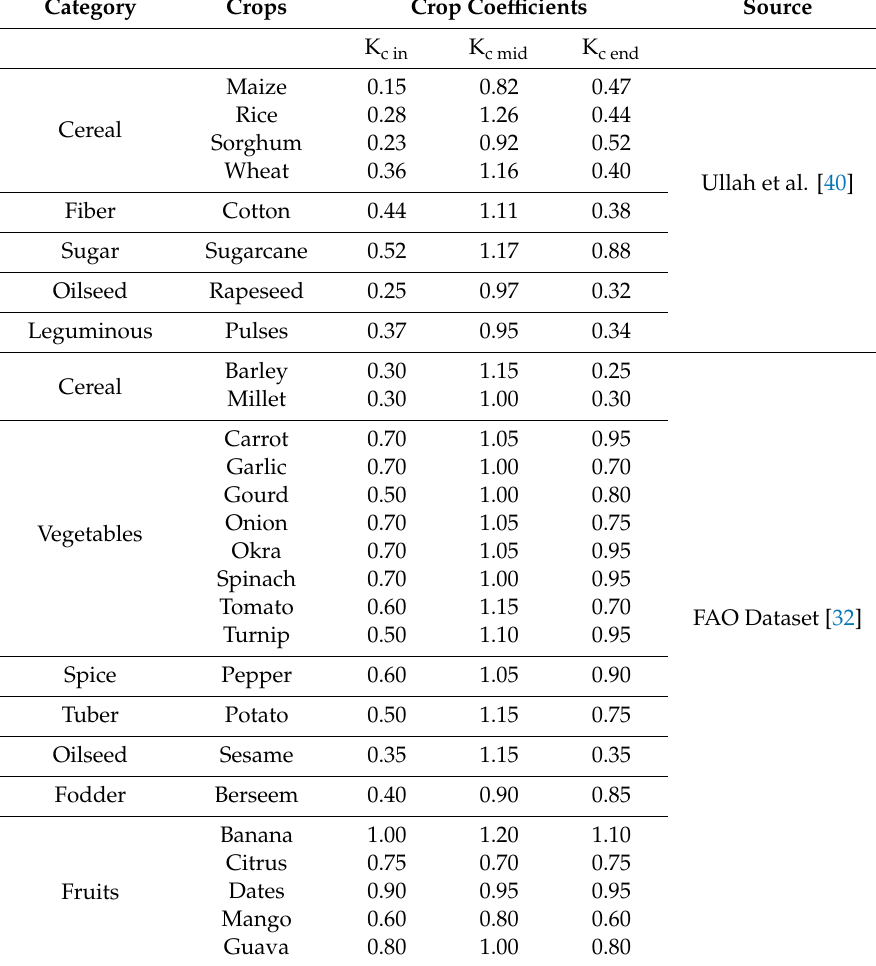
Table A1. Crop coe ffi cients (Kc) used in this